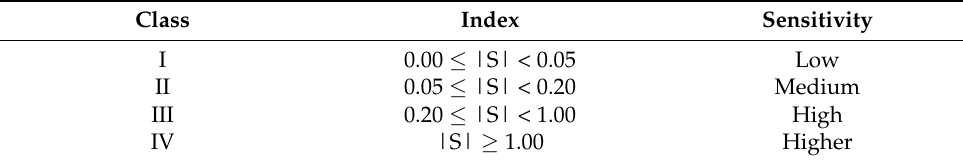
Table 1. Sensitivity classes.